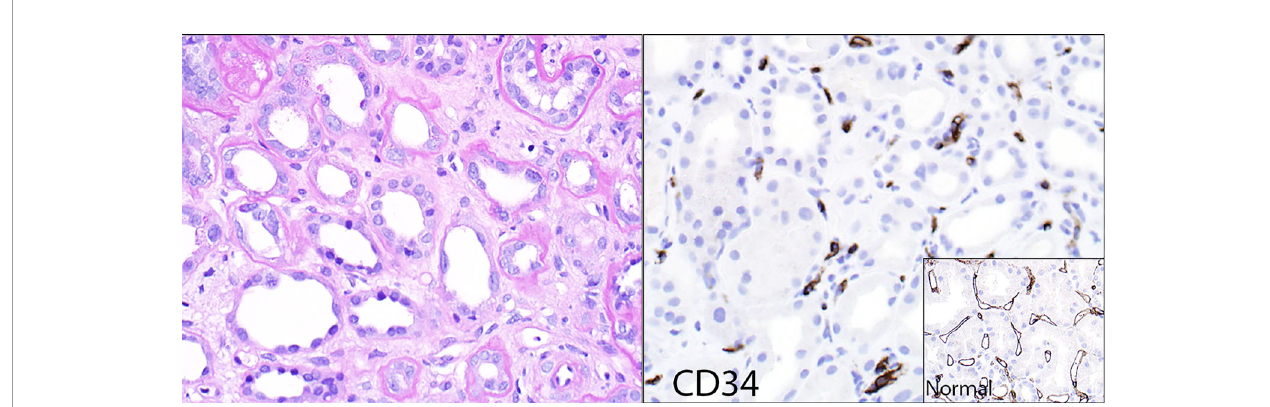
FIGURE 2 | Loss of peritubular capillaries. Some transplants with chronic ABMR show such signi fi cant loss of peritubular capillaries that the capillaries simply no longer exist to show capillaritis. The left panel (hematoxylin & eosin stain) shows minimal peritubular capillaritis; the right panel shows the endothelial marker CD34 of the same case, revealing remnants of peritubular capillaries that were presumably destroyed by rejection. The insert shows a CD34 stain of a reference kidney transplant case without peritubular capillary